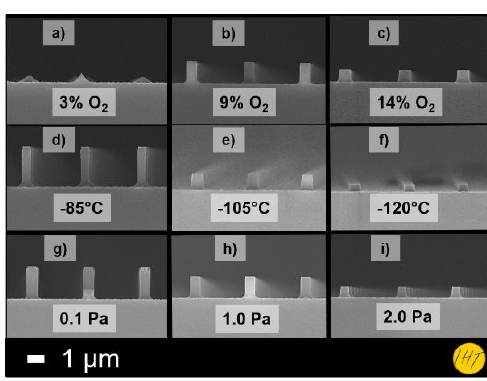
Figure 2. Cross-sectional view of 3-D (100) silicon structures prepared by different etching parameters. Effects of O 2 content ( a – c ), process temperatures ( d – f ), and pressure ( g – i ) on the fabricated features.